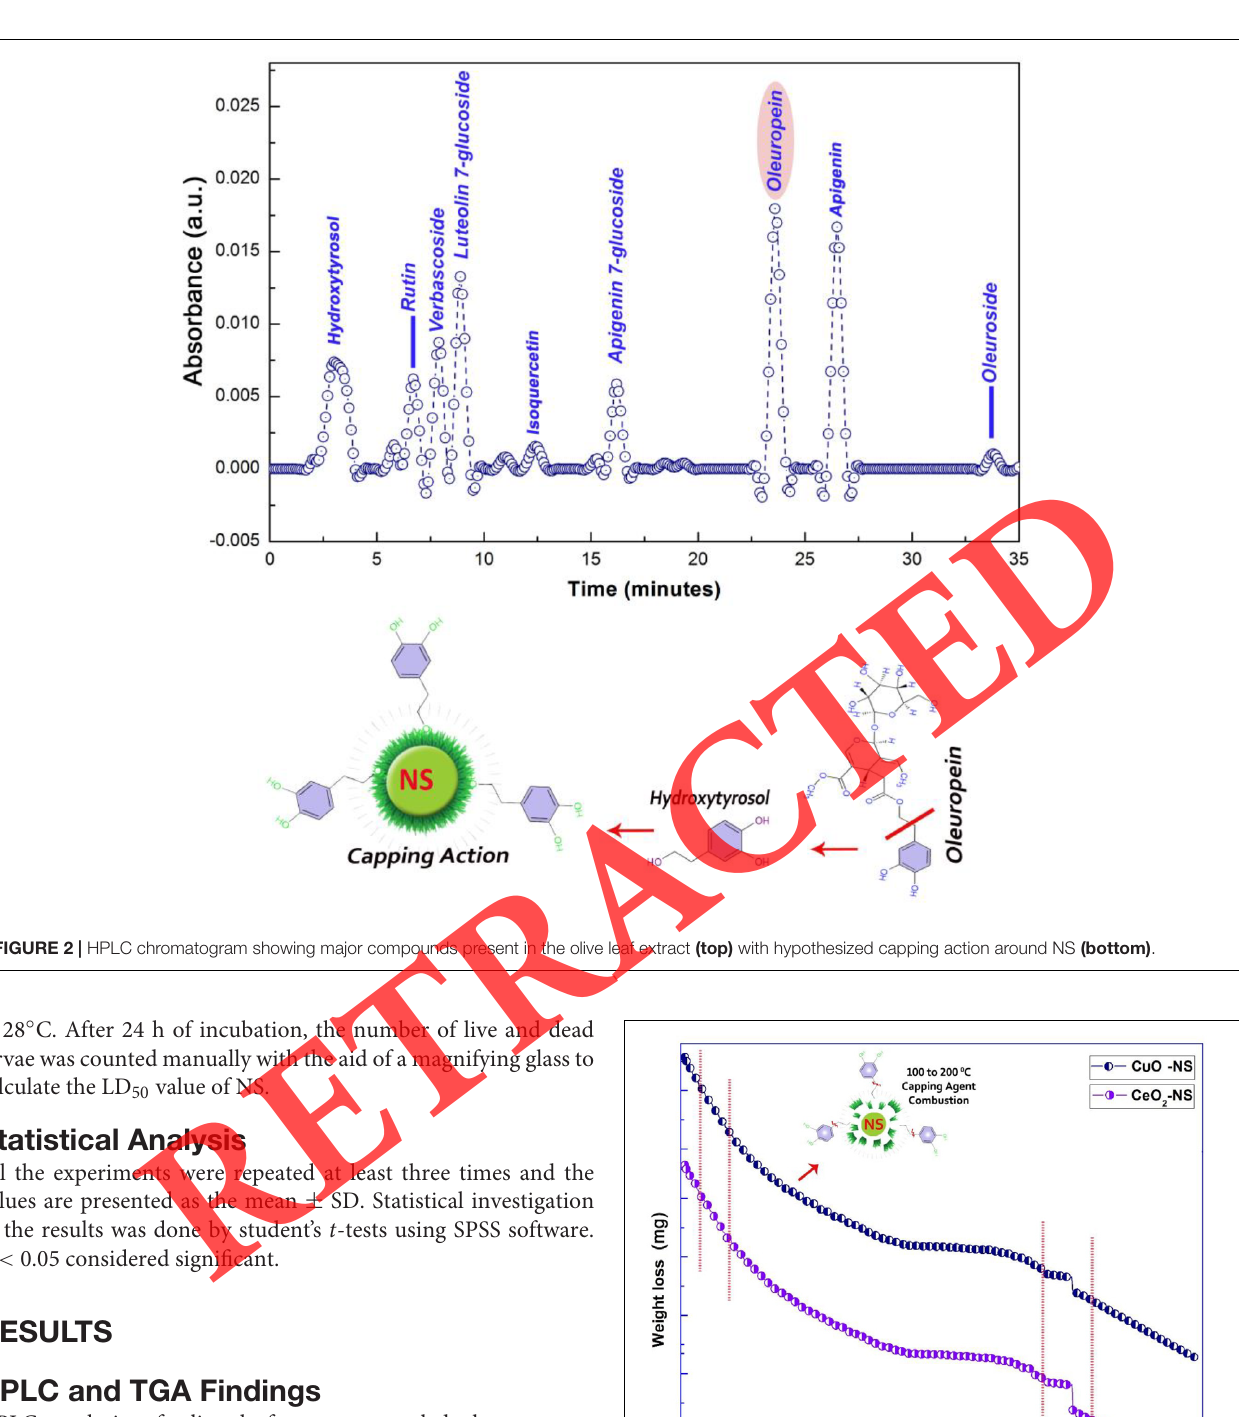
FIGURE 3 | Graphical presentation of thermal gravimetric analysis (TGA) of the green fabricated NS showing the progressive decomposition of capping agent with increasing